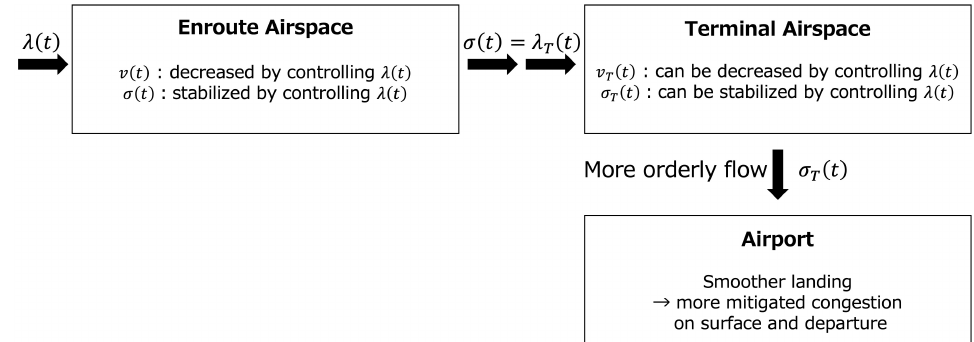
Figure 15. Arrival and departure flows in an airport and surrounding